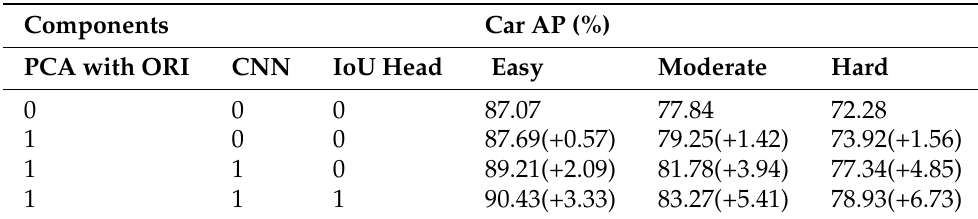
Table 2. Each component of the suggested method’s performance gain is listed between brackets. 1 means “enabled”, while 0 means